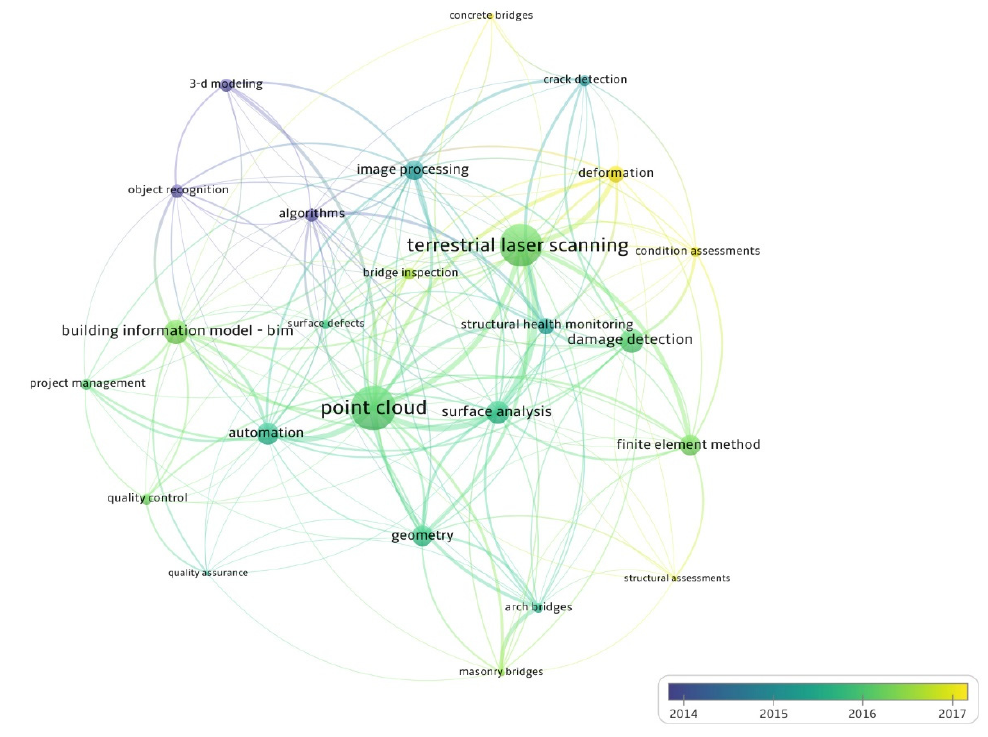
Figure 3. Network of co-occurring keywords. Table 2. List of keywords and related network data.